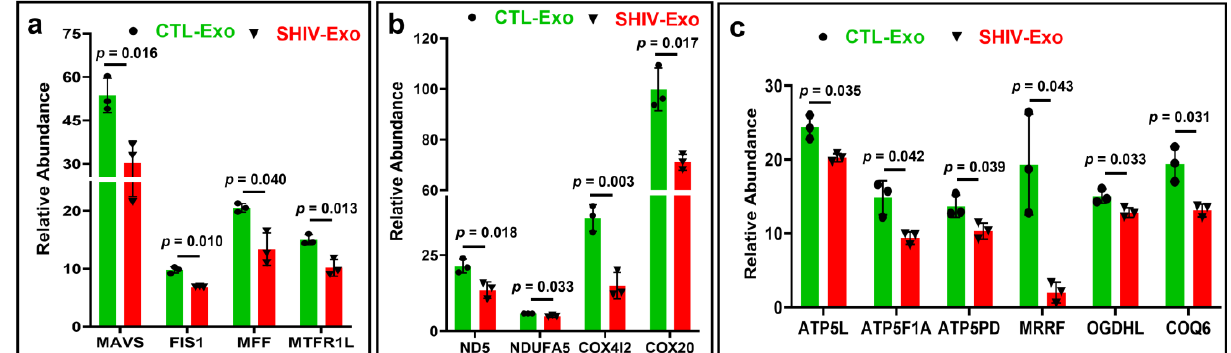
Figure 6. Decreased expression of proteins involved in mitochondrial biogenesis and ATP production in SHIV-Exo. ( a – c ) Differential expression of mitochondrial proteins in CTL-/SHIV-Exo quantified by proteomic analysis. Proteins that exhibited group differences are shown as bar graphs with green and red for CTL-Exo and SHIV-Exo, respectively. Plasma exosomes were isolated from three SHIV-infected and three uninfected RM (N = 3/group). Graphs show mean ± SD of relative abundance calculated from four experimental replicates/sample. Protein group ‘a’ and ‘c’ passed the Shapiro–Wilk normality test and protein group ‘b’ passed the D’Agostino and Pearson normality test. The data sets were followed by unpaired t test with Welch correction for normally distributed data. The protein coding gene names are presented here, and they were described in the text. CTL-Exo: Plasma exosomes isolated from uninfected RM; SHIV-Exo: Plasma exosomes isolated from SHIV-infected RM. q-values for: ( a ) 0.022, 0.022, 0.039, 0.022; ( b ) 0.024, 0.037, 0.013, 0.024; and ( c ) all of them are 0.043. Age-adjusted p -values were presented in the Supplementary Materials File S1.